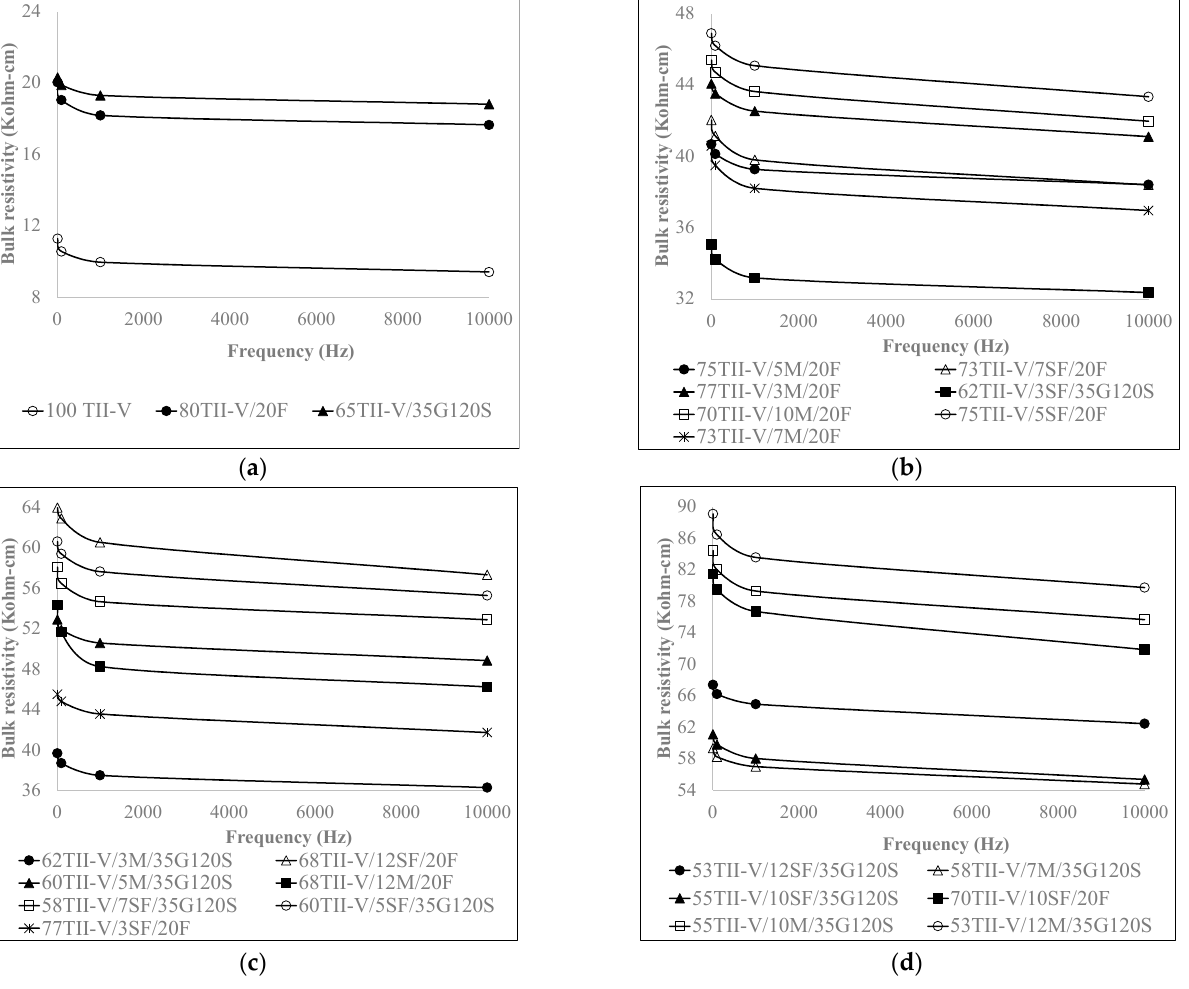
Figure 4. Influence of frequency on BR at 91 days on ( a ) control and binary mixtures, and ( b – d ) ternary mixtures.